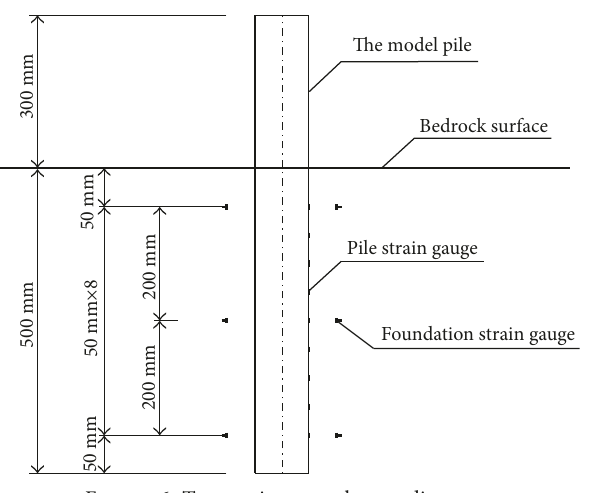
Figure 6: Test strain gauge layout diagram.